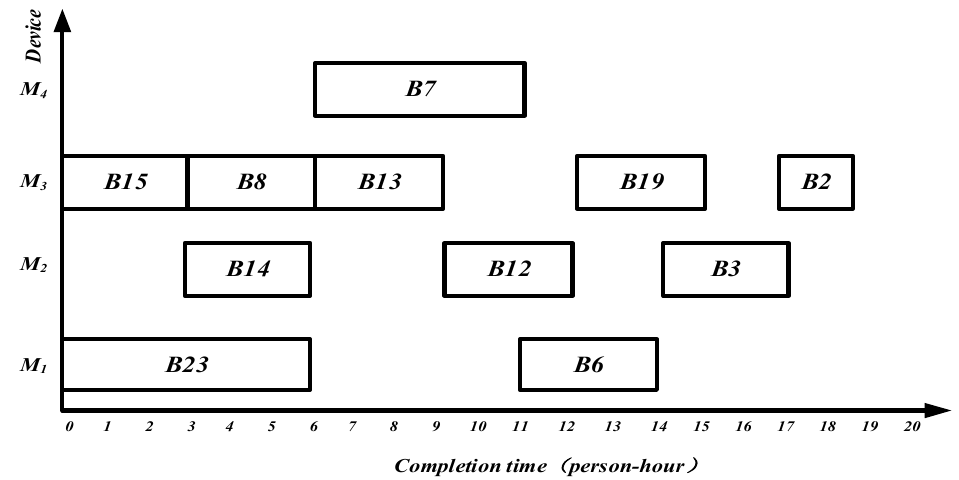
Figure 22. Gantt chart by the NR for workshop f 2 with 19 person-hours.